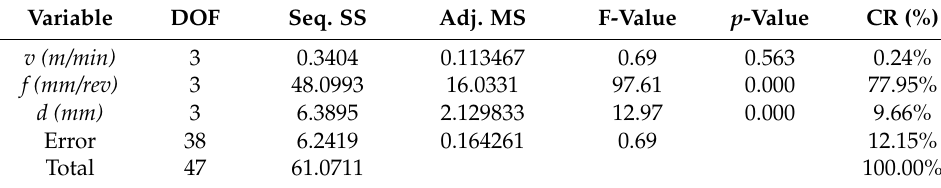
Table 6. Analysis of variance and percentage contribution results for Ra.